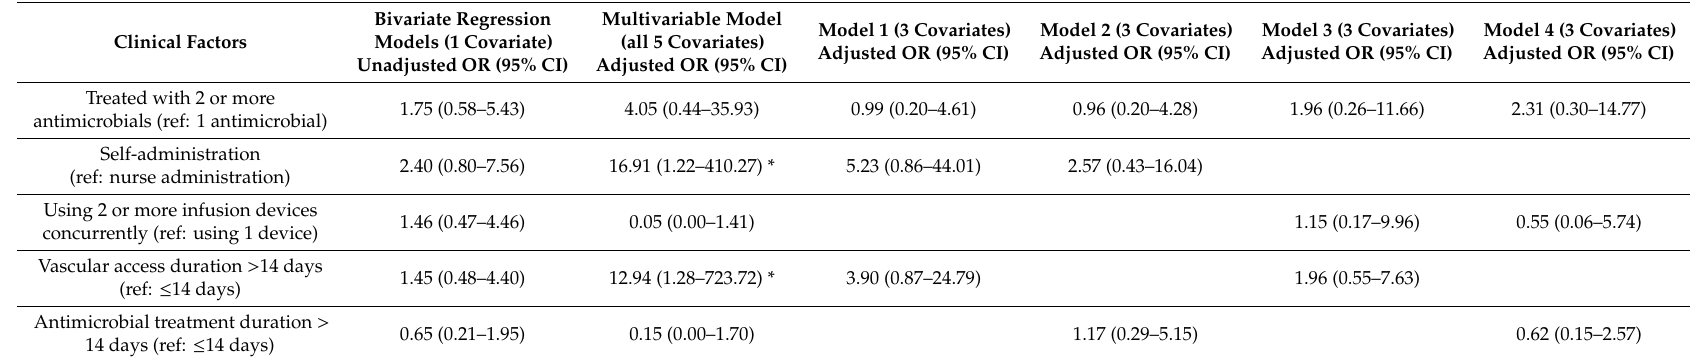
Table 3. Results of bivariate and multivariate exact logistic regression models to examined clinical factors associated with an adverse event ( n = 86 OPAT